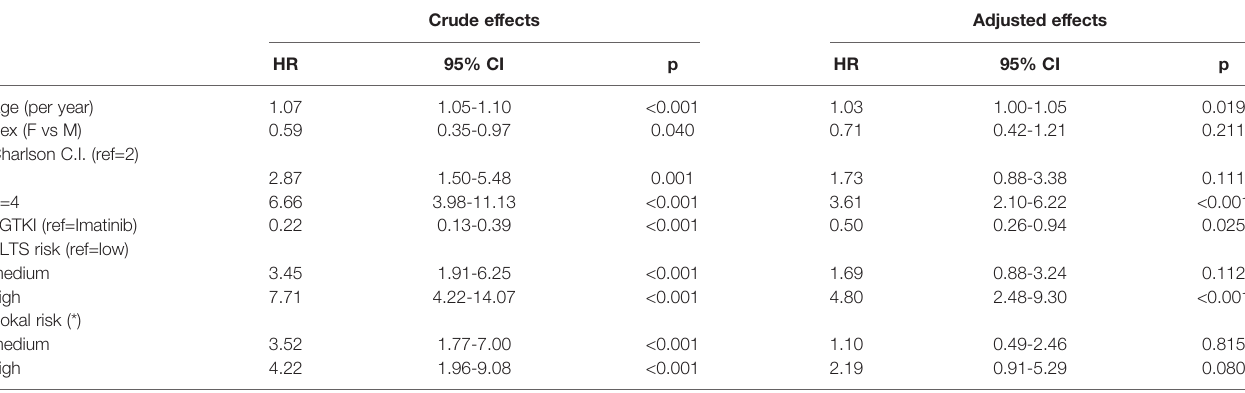
TABLE 3 | Role of prognostic variables and front-line treatments on overall survival of CML